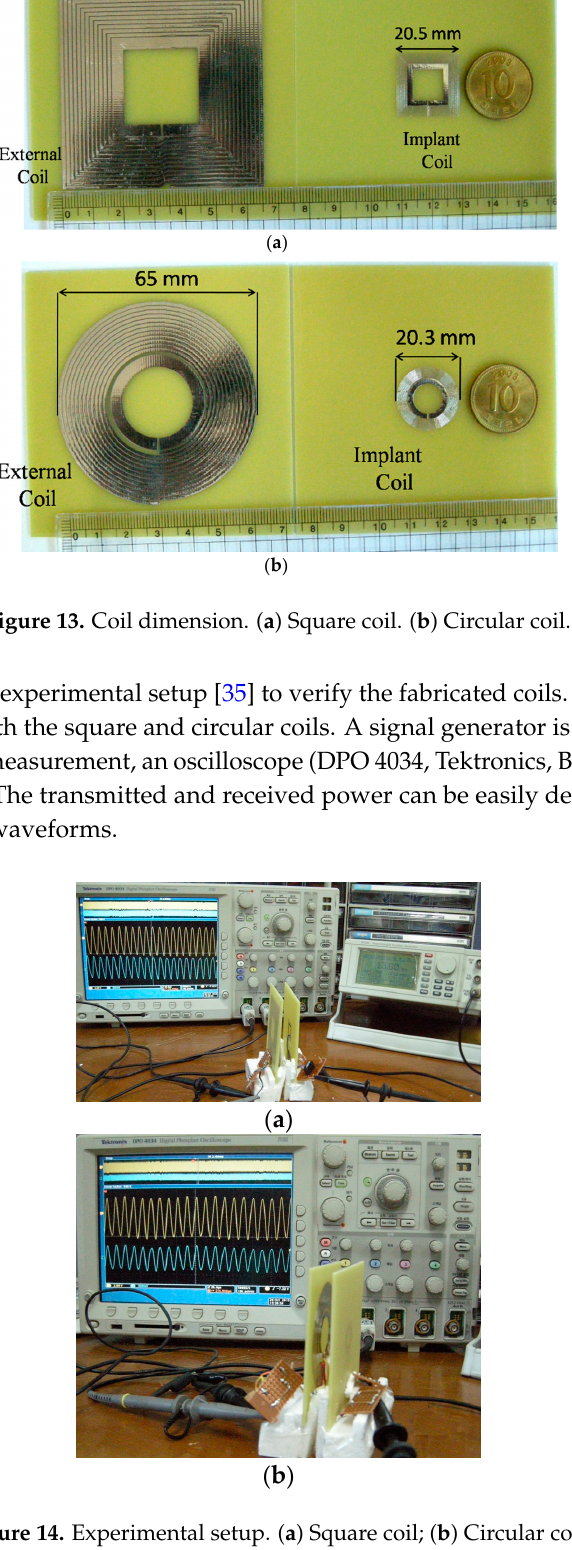
Figure 13. Coil dimension. ( a ) Square coil. ( b ) Circular coil. Figure 13 . Cont. Table 4. Electrical Specification.